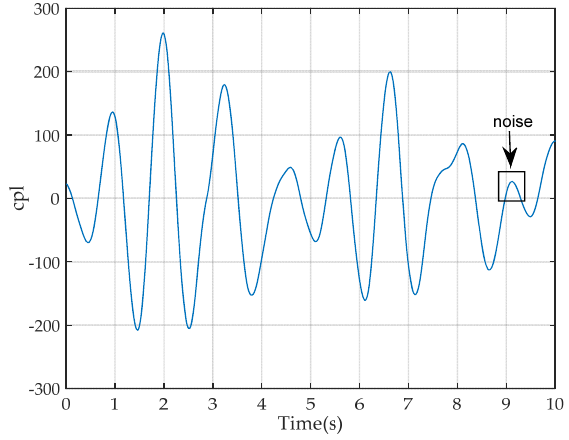
Figure 3. Wavelet variance.